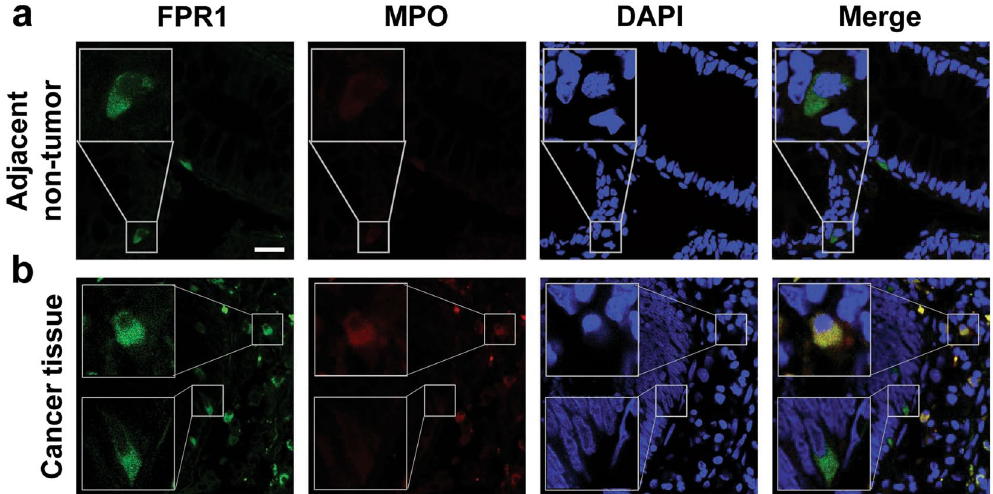
Figure 2. Immunofluorescence staining of FPR1 in human CRC tissues. Frozen sections of the adjacent normal tissues ( a ) and CRC tissues ( b ) were stained by immunofluorescence for the expression of FPR1 (FITC, green) and MPO (Cy3, red), as described in Materials and Methods . Cell nuclei were stained with DAPI (blue). Images shown are representative of three independent experiments with similar results. Scale bar, 25 µ